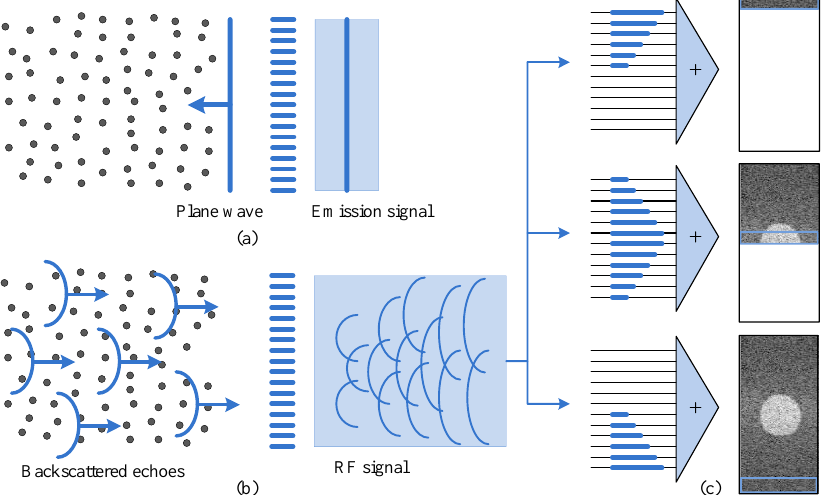
Figure 3. The transmit–receive scheme [21,28]. ( a ) The single plane wave transmit method. ( b ) Radio frequency (RF) signals. ( c ) The beamforming procedure in the receiving mode.